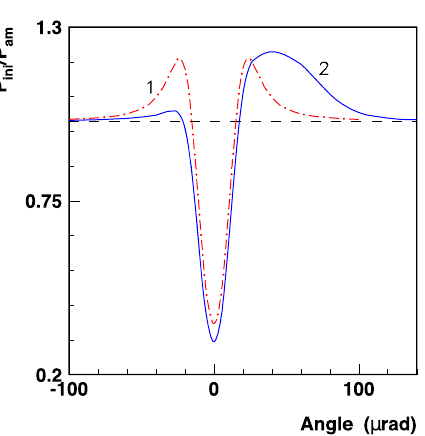
Fig. 4 The simulated dependence of INI rate for 180 GeV/c positive hadrons on the orientation angle of the crystal. Curve 1 is calculated for a straight 4 mm thick, while curve 2 is for a 61 μ rad bent crystal of the same thickness (the same as Fig.